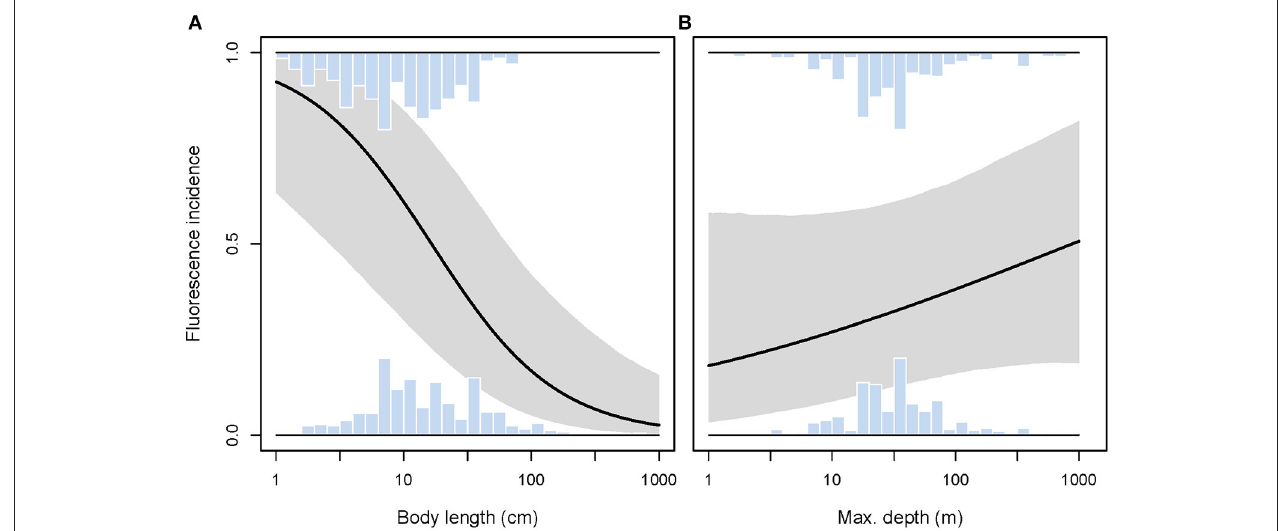
FIGURE 10 | Incidence of red fluorescence in response to maximum body length (A) and maximum depth (B) per species. Marginal histograms display the relative frequency distributions of raw species values. Predicted incidence (black line) and its 95% credibility interval (shaded area) are extracted from binomial models corrected for shared species ancestry. Note log 10 -scale on x -axes.